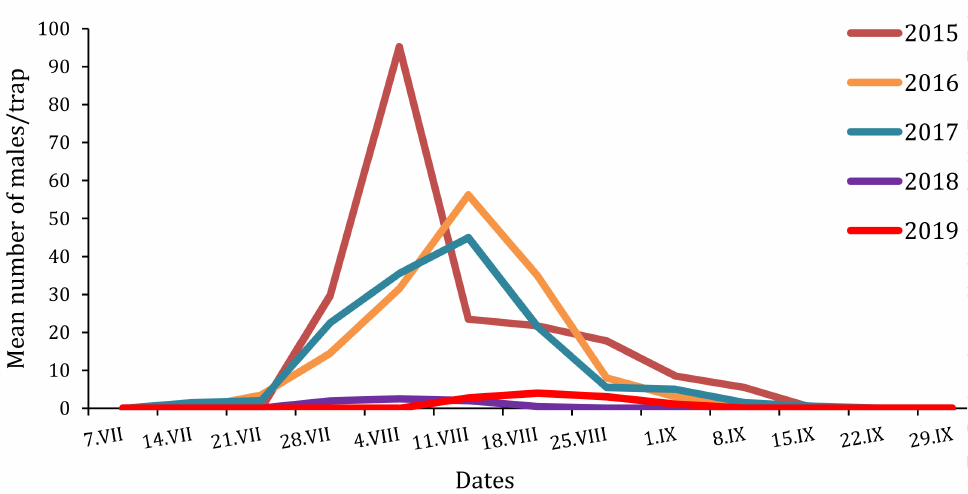
Figure 3. Flight phenologies of T. pityocampa males trapped in the Petacciato (Italy) recreational woodland area from 2015 to 2019.